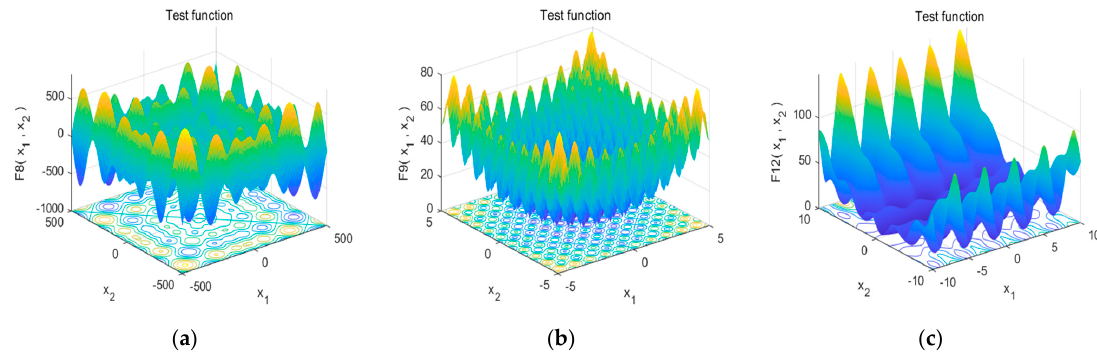
Figure 8. Distribution diagram of different continuous multimodal test function values. ( a ) F8 function; ( b ) F9 function; ( c ) F12 function.